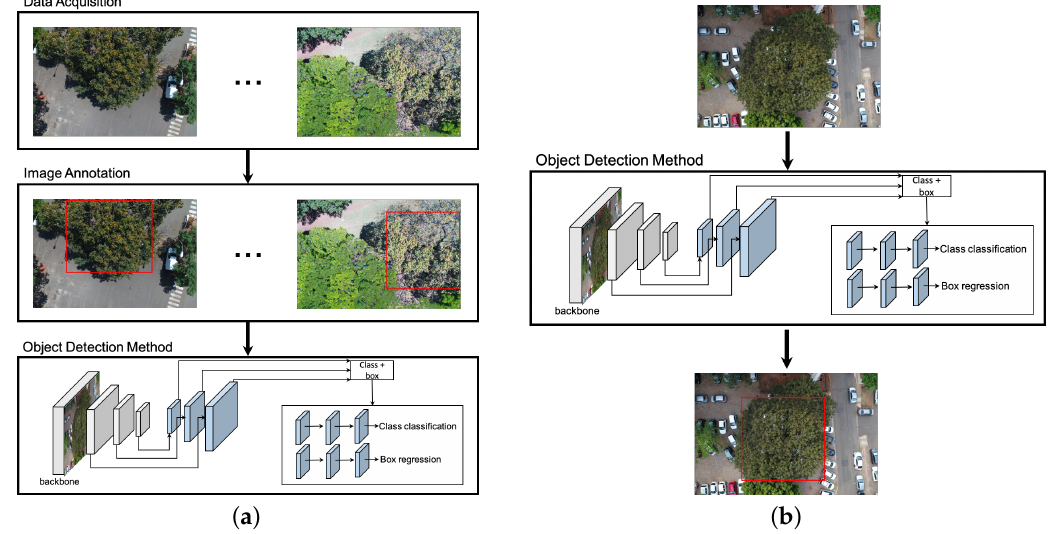
Figure 1. General processing chain: ( a ) UAV images at different seasons were captured and annotated by a specialist. A set of images were selected to train the detection network. ( b ) Once trained, the network was applied to detect cumbaru trees in test images. The object detection method in this figure corresponds to RetinaNet, although other methods (e.g., Faster-RCNN and YOLOv3) can be